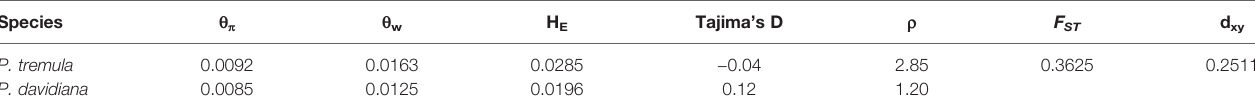
TABLE 4 | Mean ( ± standard deviation) values of population genomic statistics ( q p , q w, H E, Tajima ’ s D, r , F ST and dxy) comparisons between P. tremula and P. davidiana population. Species q p q w H E Tajima ’ s D F